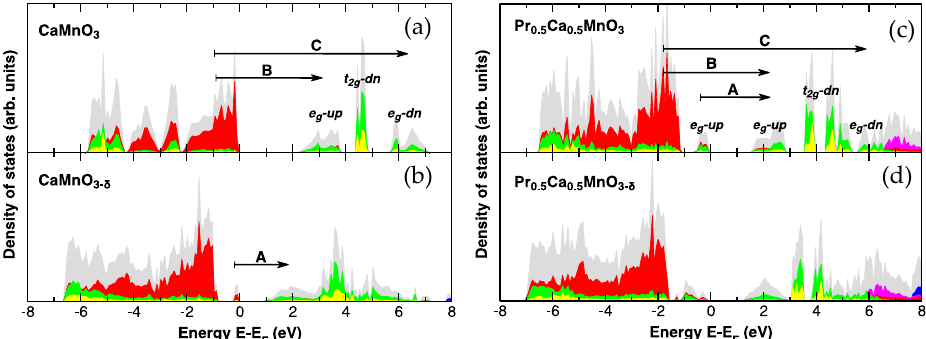
Figure 8. Total and projected DoS of ( a ) CaMnO 3 , ( b ) CaMnO 3 including O-vacancy, ( c ) Pr 0.5 Ca 0.5 MnO 3 , and ( d ) Pr 0.5 Ca 0.5 MnO 3 including O-vacancy. The graph shows the total DoS (grey) and the projected DoS for O p (red), Mn t 2g (green), Mn e g (yellow), Ca d (blue), and Pr f (magenta). The arrows indicate the dipole-allowed optical transitions within the Mn d orbitals (A) and from O p states to the majority (B) and minority (C) Mn e g states.